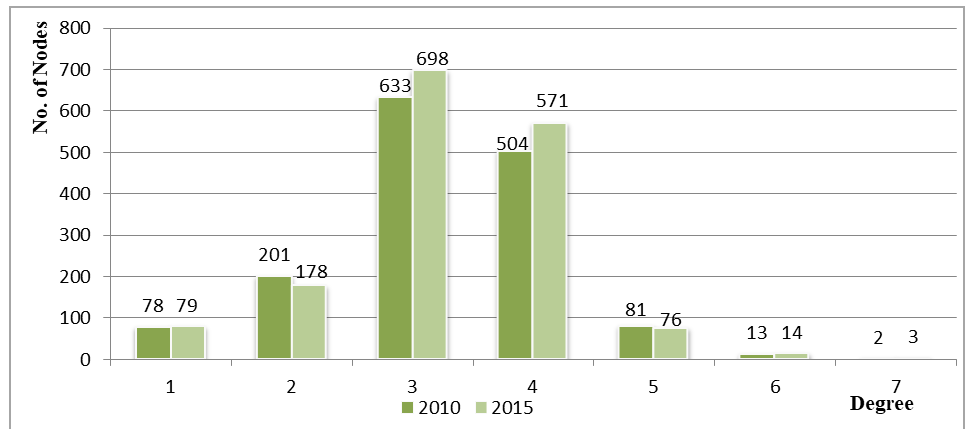
Figure 5. Network characteristics of degree in BHT urban agglomeration.